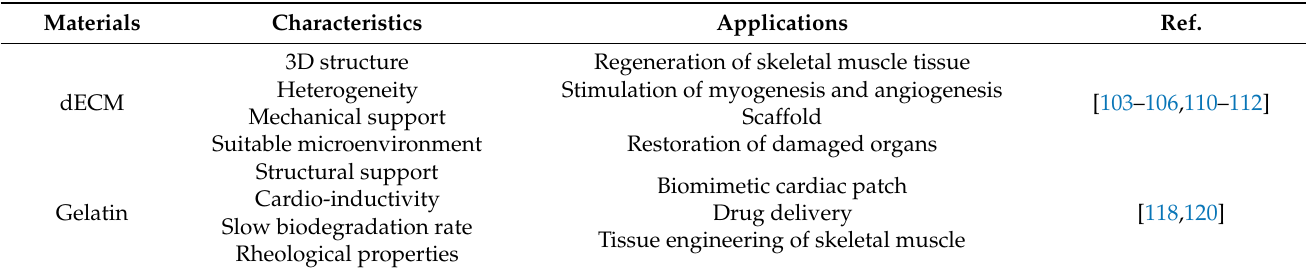
Table 3. Characteristics and applications of biomaterials in the cardiovascular